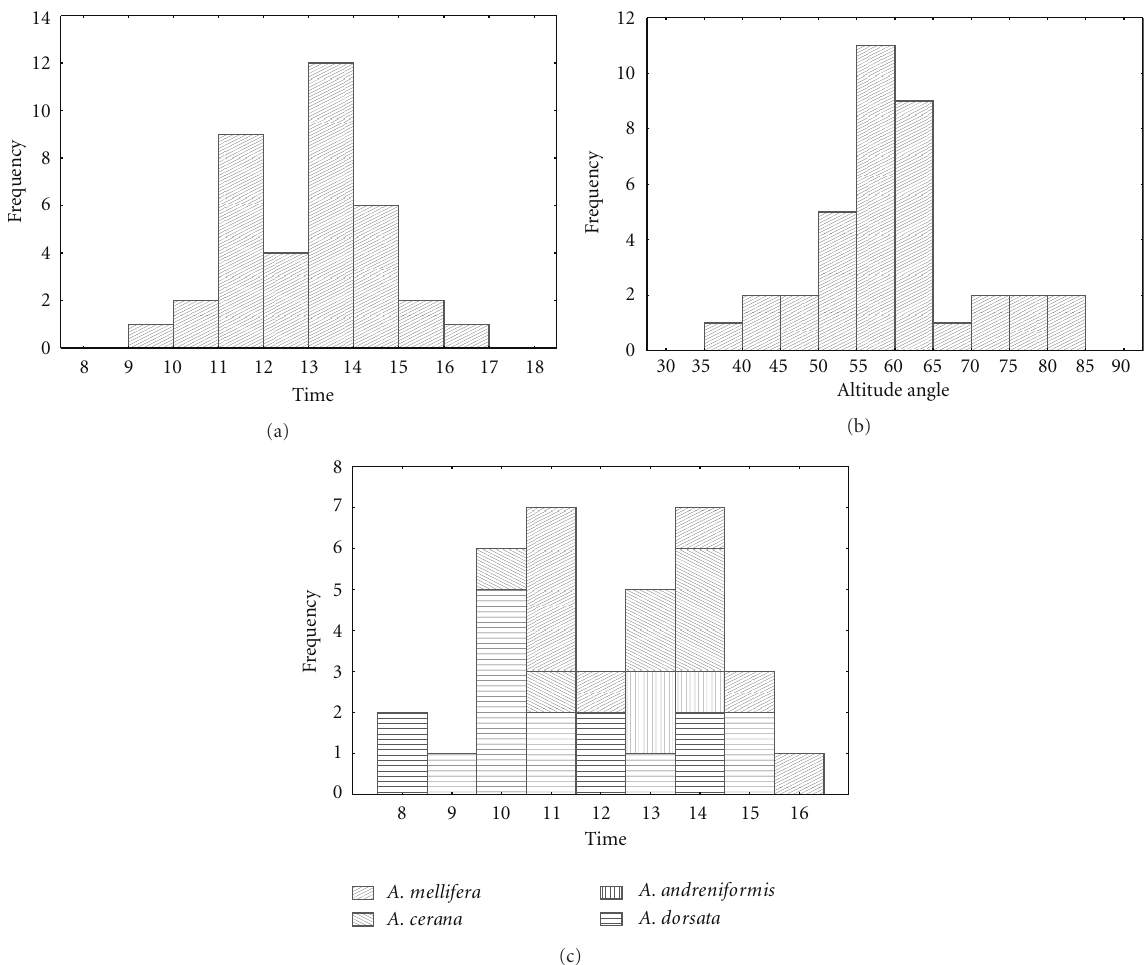
Figure 4: (a) Frequency distribution for local clock time of absconding by the red dwarf honeybee at Chom Bueng, Thailand (13.37N, 99.35E) during 2007–2009 ( n = 37) [23]. (b) Frequency distribution for absconding by the red dwarf honeybee at Chom Bueng, Thailand (13.37N, 99.35E) with respect to altitude angle of the sun (in degrees) during 2007–2009 ( n = 37) [23]. (c) Frequency distribution for local clock time of absconding by A. dorsata ( n = 3 [35], n = 14 [36]), A. cerana ( n = 1 [37], n = 4 Duangphakdee, O. personal observation, n = 2 Wongvilas, S. pers. comm.), A. mellifera ( n = 6 [38], n = 2 [39]), and A. andreniformis ( n = 3 Wongvilas, S. pers.